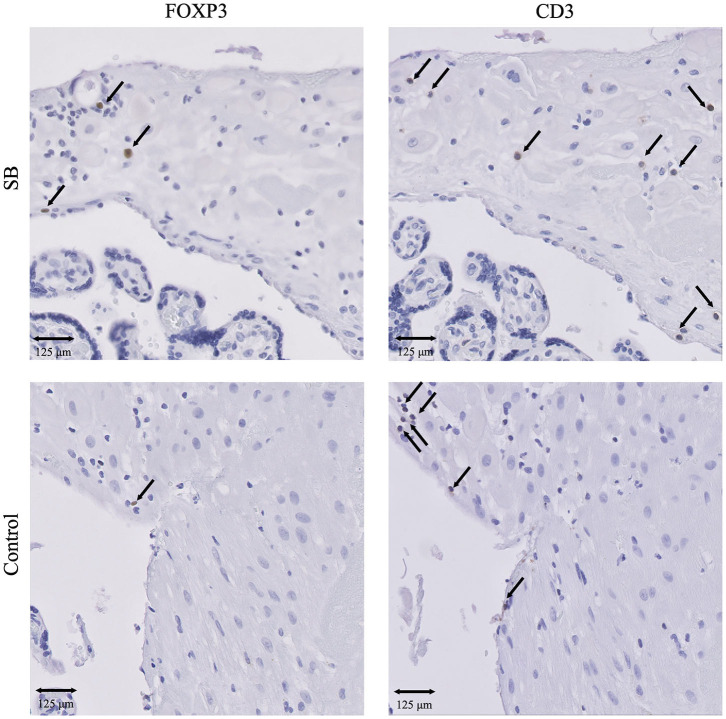
IHC results of T cells and Treg cells in SB and controls. Presence of CD3+ T cells and FOXP3+ Treg cells in SB (n = 64) and controls (n = 42). 20x magnification. Arrows indicate all FOXP3+ cells. Arrows set as example for CD3+ T cells, not all positive cells are indicated. SB, stillbirth.